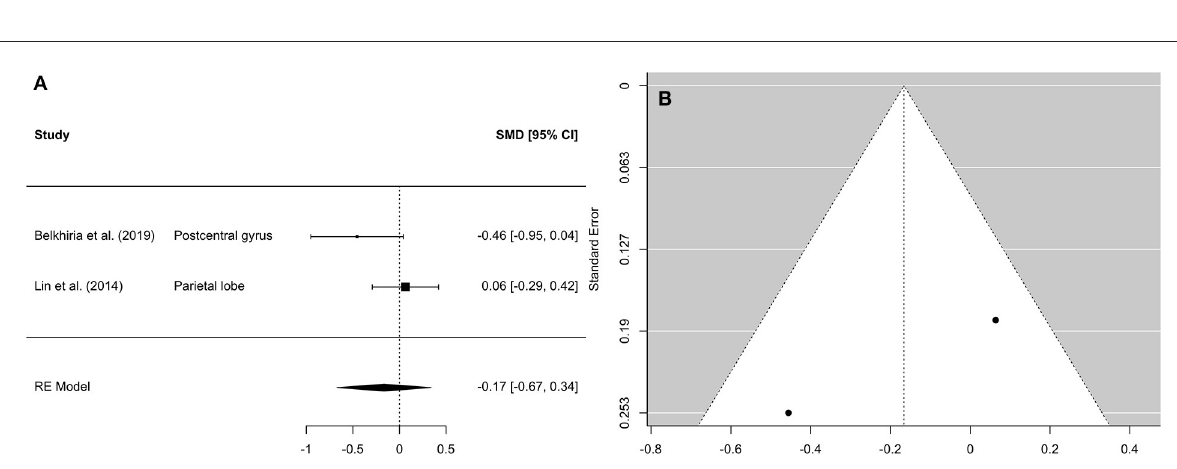
FIGURE5 Forest plot (A) and funnel plot (B) of the parietal lobe analysis. In the forest plot (A) negative values on the x-axis indicate gray matter atrophy.